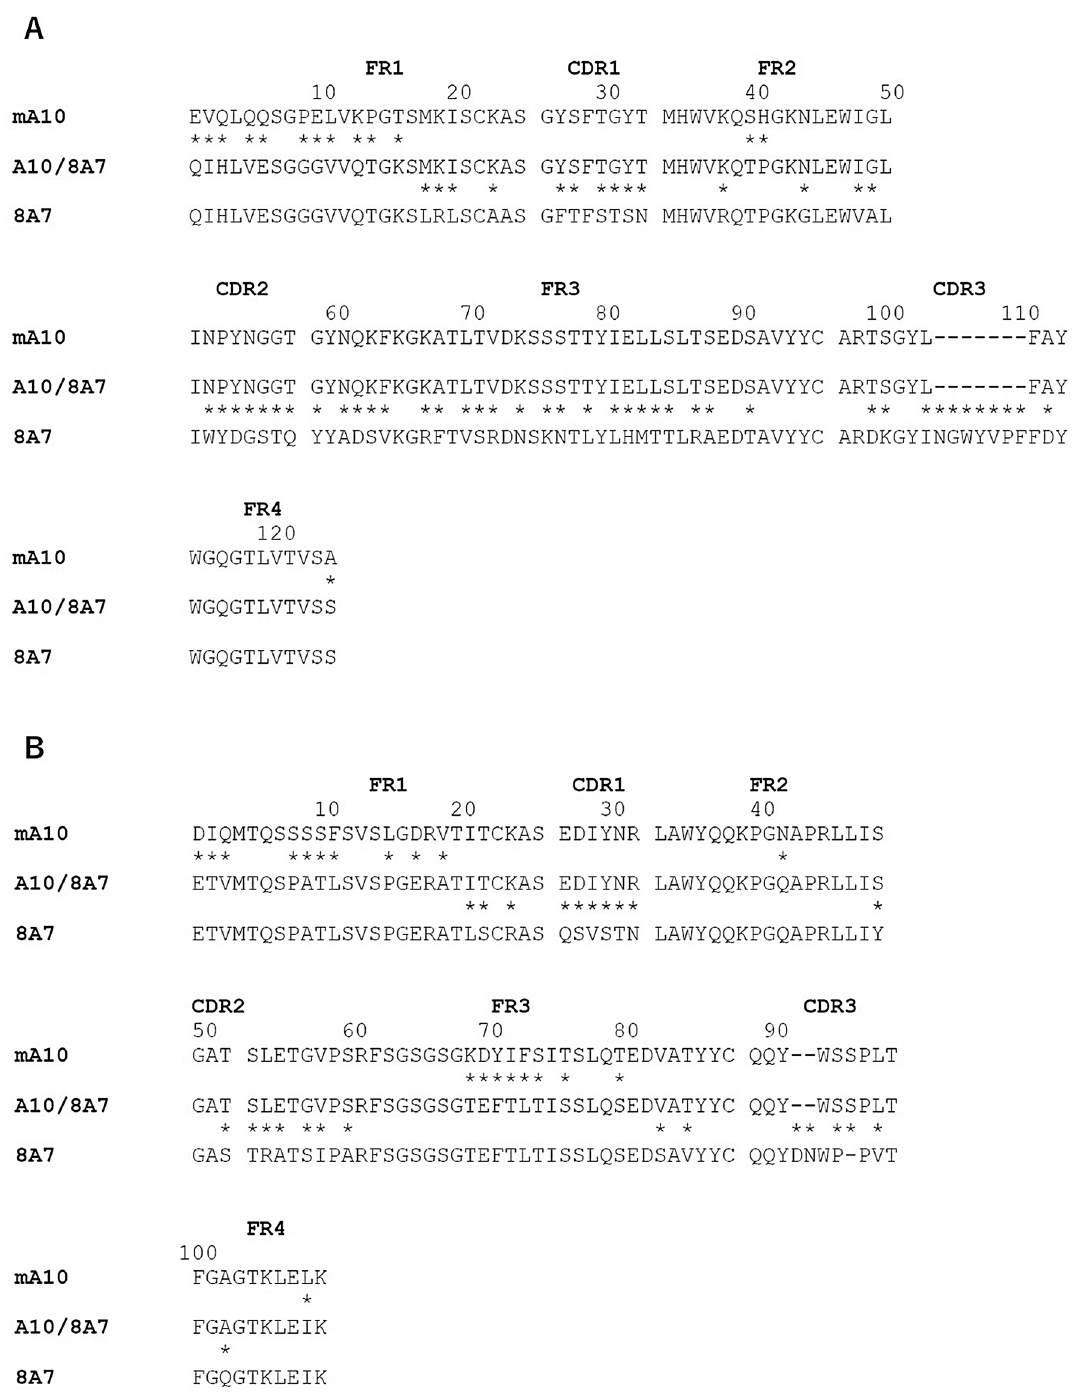
Figure 1. Amino acid sequence alignment of the heavy ( A ) and light ( B ) chain variable domains of mouse A10 (mA10), humanized A10/8A7, and human antibody framework 8A7. The FRs and CDRs in the variable domains of the mouse or human antibody sequences were determined by IMGT numbering scheme, respectively. Asterisks (*) indicate the difference between each paired amino acid sequence, and hyphens (−) indicate